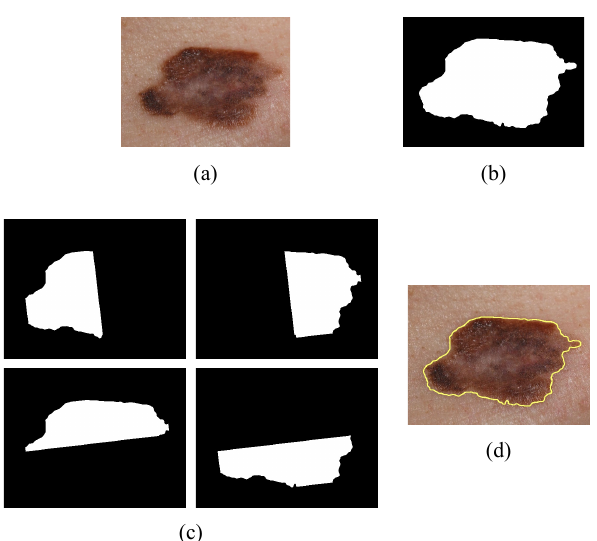
Figure 3. Example of the detection and classification of melanoma corresponding to Algorithm 1. ( a ) the input image I ( a ) ; ( b ) corresponds to the identification of possible cases of melanoma after noise and skin removal I ( b ) ; ( c ) shows the semiplanes formed for the evaluation of symmetry a ; ( d ) the edge identified d